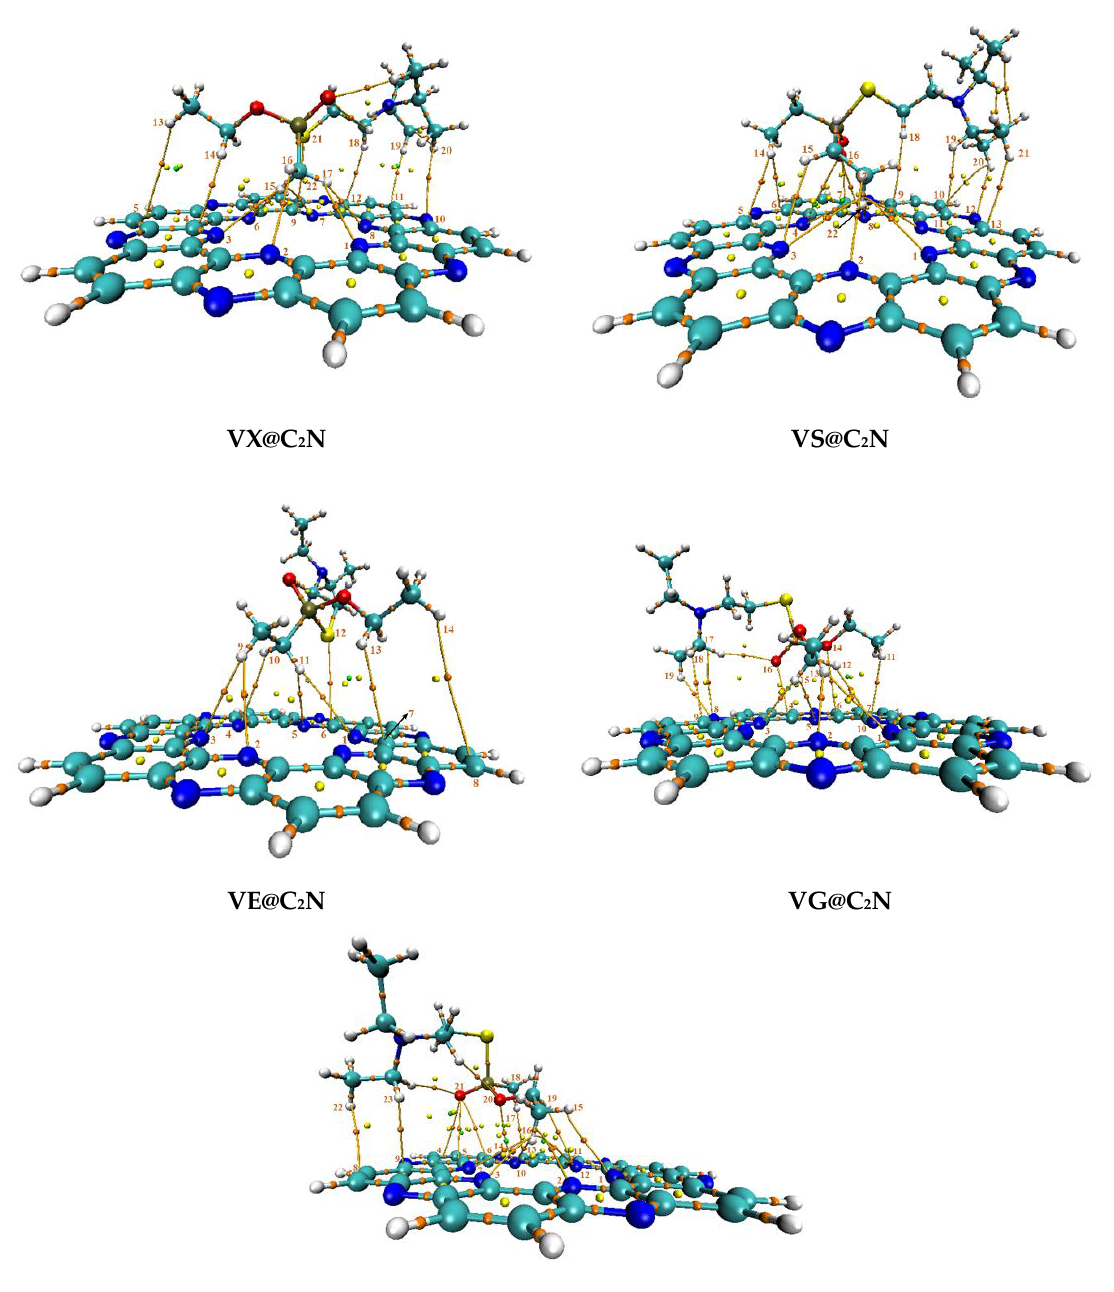
Figure 6. QTAIM analysis of studied V-series@C 2 N complexes and yellow lines between nerve agent molecules and C 2 N sheet indicates bond paths, whereas orange-colored dots present on bond paths show the bond critical points (BCPs).